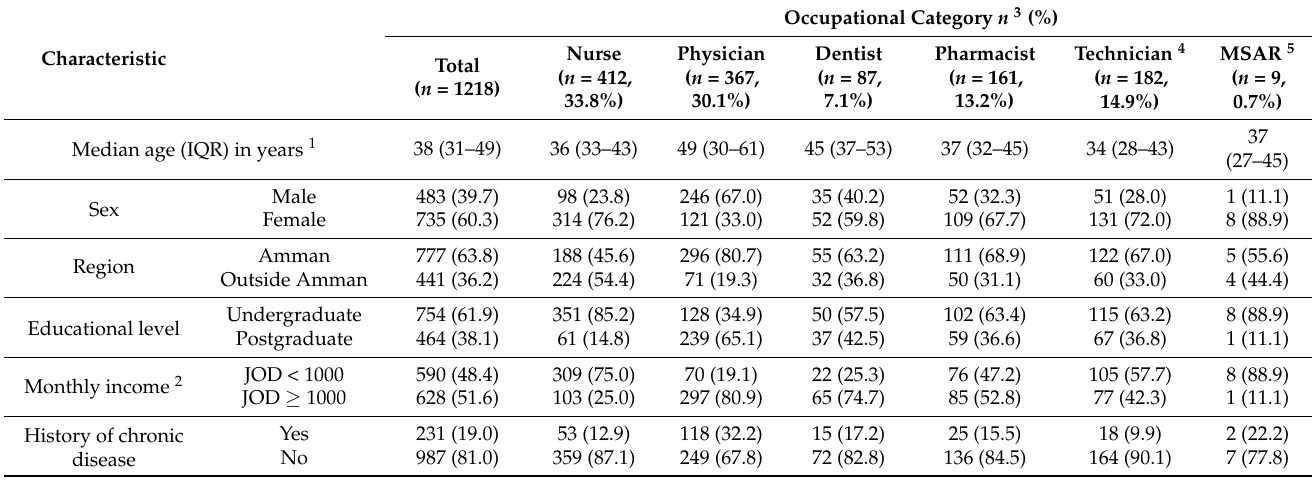
Table 1. Characteristics of the study sample divided by occupational